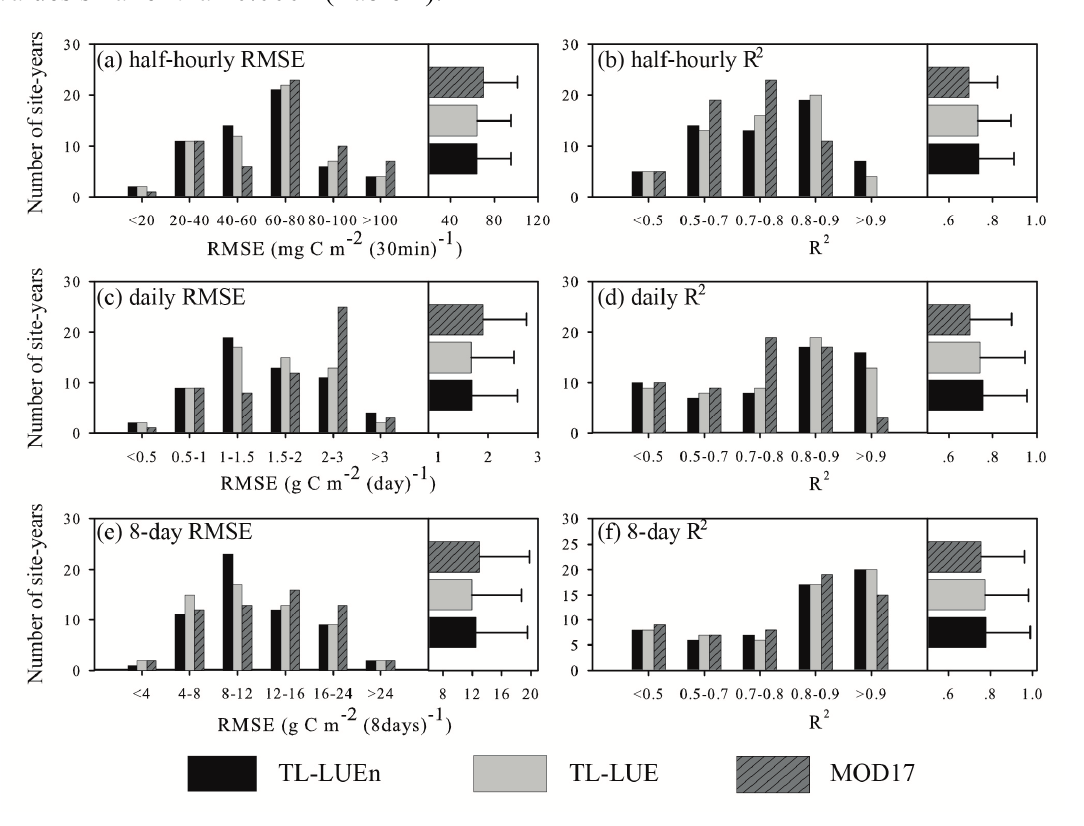
Figure 4. The number of site-years within different RMSE and R 2 classes ( left ) and the averages of RMSE and R 2 ( right ) of gross primary productivity (GPP) simulated using the TL-LUEn, TL-LUE, and MOD17 models in 58 validation site-years at half-hourly ( a , b ), daily ( c , d ), and 8-day ( e , f ) temporal scales,